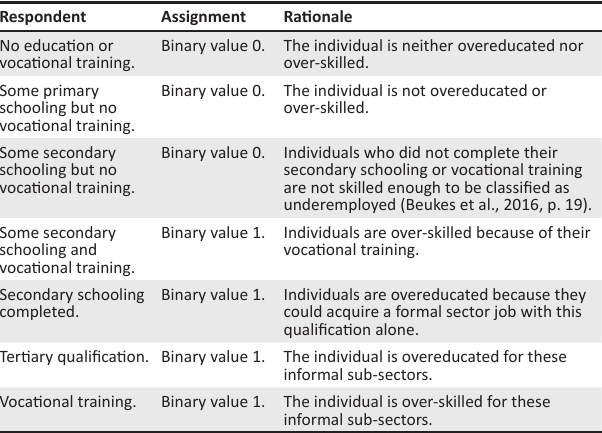
TABLE 1: Skills-related underemployment classification scheme. Respondent Assignment Rationale